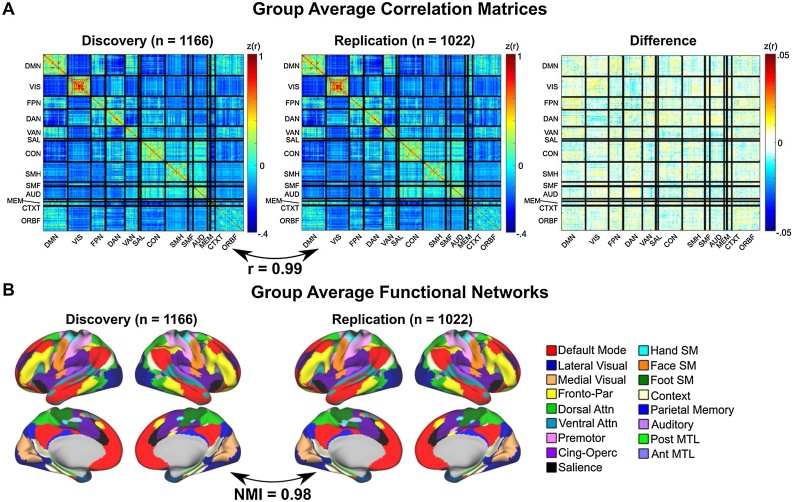
ABCD RSFC and functional network architecture is highly reproducible. (A) Group average correlation matrices in a discovery and replication set, and the difference (Discovery - Replication). Color bar represents Fisher Z-transformed correlations between ROIs. (B) Group average functional networks. The correlation across every ROI pair between the discovery and replication dataset was r = 0.99. Functional network architecture was similarly highly reproducible with a normalized mutual information value (NMI) of 0.98. Fronto-Par = Frontoparietal; Dorsal Attn = Dorsal Attention; Ventral Attn = Ventral Attention; Cing-Oper = Cingulo-opercular; Hand SM = Hand Somatomotor; Face SM = Face Somatomotor; Foot SM = Foot Somatomotor; Post MTL = Posterior medial temporal lobe; Ant MTL = Anterior medial temporal lobe.